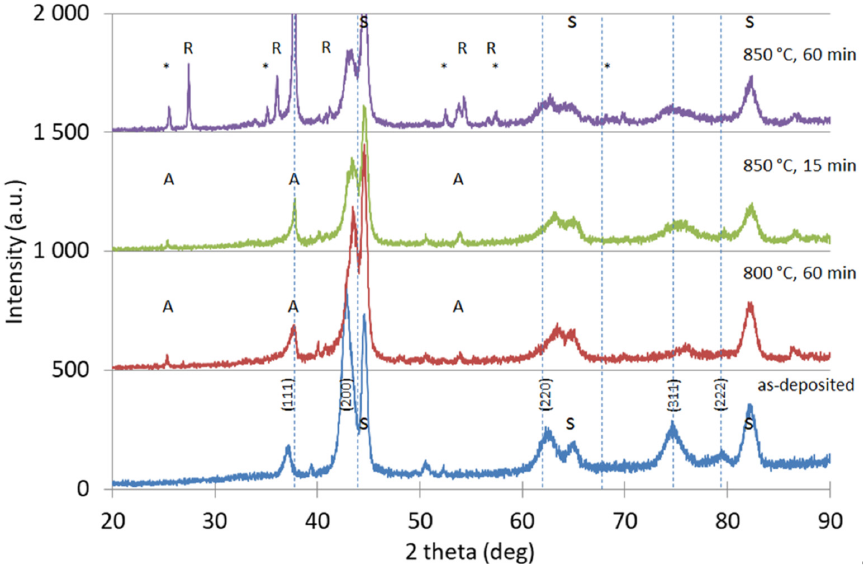
Figure 4. X-ray diffraction patterns of as-deposited and oxidized TiAlN hard coatings. The oxida- tion was performed for different temperatures and times (designation of peaks: s—substrate, different temperatures and times (designation of peaks: s—substrate, A—anatase, R—rutile, *— α -aluminum A—anatase, R—rutile, *— α -aluminum oxide).